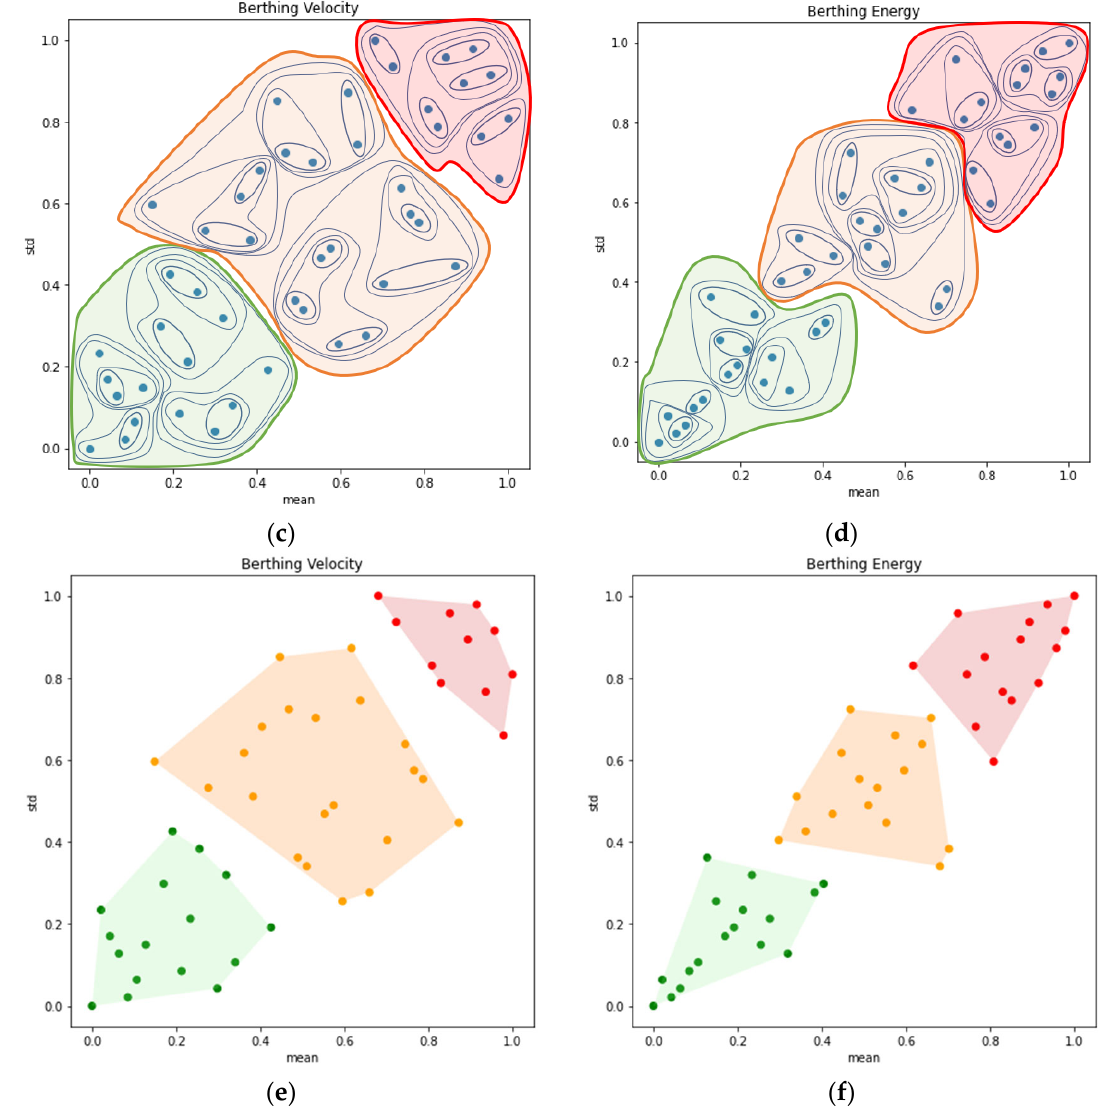
Figure 11. The process and results of data aggregation according to the dendrogram: ( a , c ) early and final stages of berthing velocity aggregation, respectively; ( b , d ) early and final stages of berthing energy aggregation, respectively; ( e , f ) results of berthing velocity and energy aggregations, respectively.